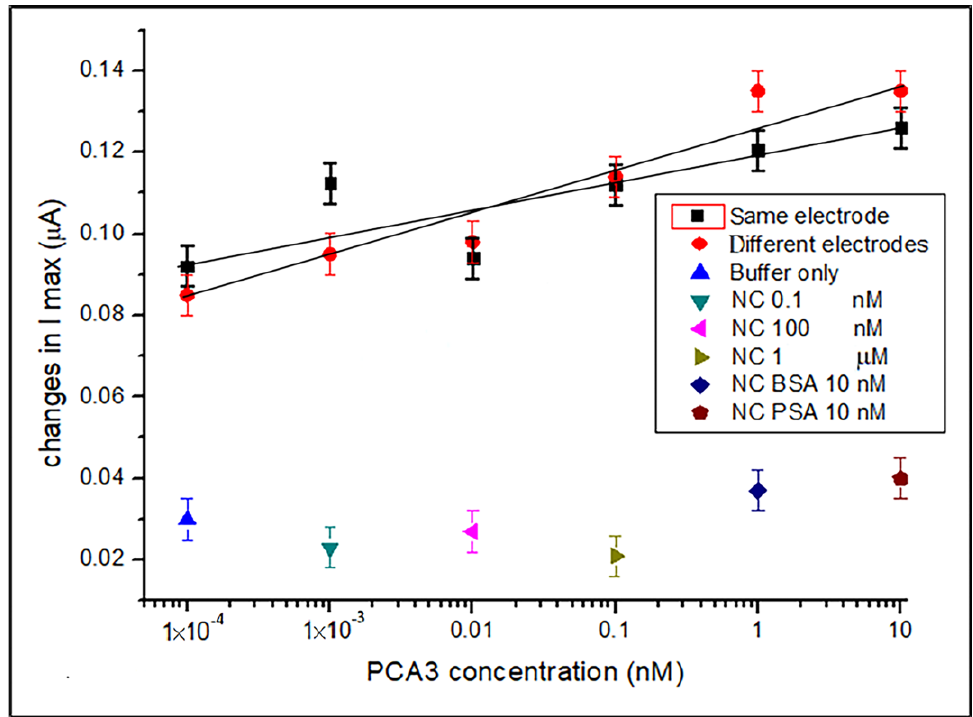
Figure 3. Dependences of the DPV peak current values vs. concentration of PCA3 in buffer solutions: black squares and line correspond to DPV measurements on the same electrode with PCA3 added sequentially; red circles and line correspond to DPV recorded on different electrodes. Individual data points below correspond to negative control tests using scrambled PCA3, BSA, and PSA.